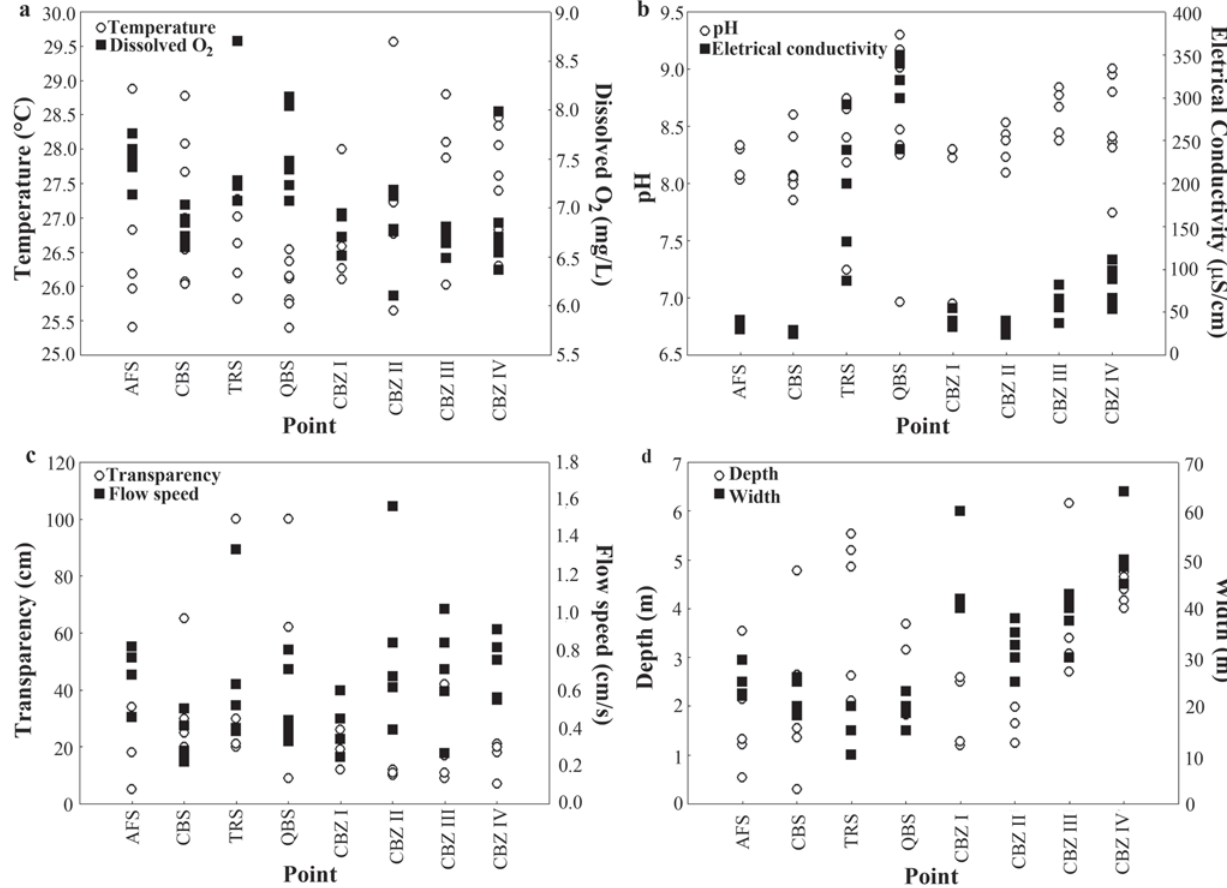
Fig. 4. Values of the local variables of temperature and dissolved oxygen ( a ), pH and electrical conductivity ( b ), transparency and flow velocity ( c ), and width and depth ( d ), obtained in the headwaters of the Cuiabá River between November 2007 and March